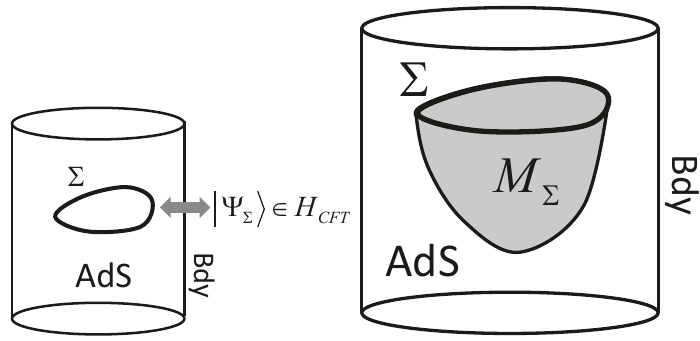
Figure 1 . The left picture is a sketch of surface/state correspondence in the context of AdS/CFT [44]. The right picture explains the new correspondence proposed in the present pa- per, based on path-integrations in surface/state duality for Euclidean